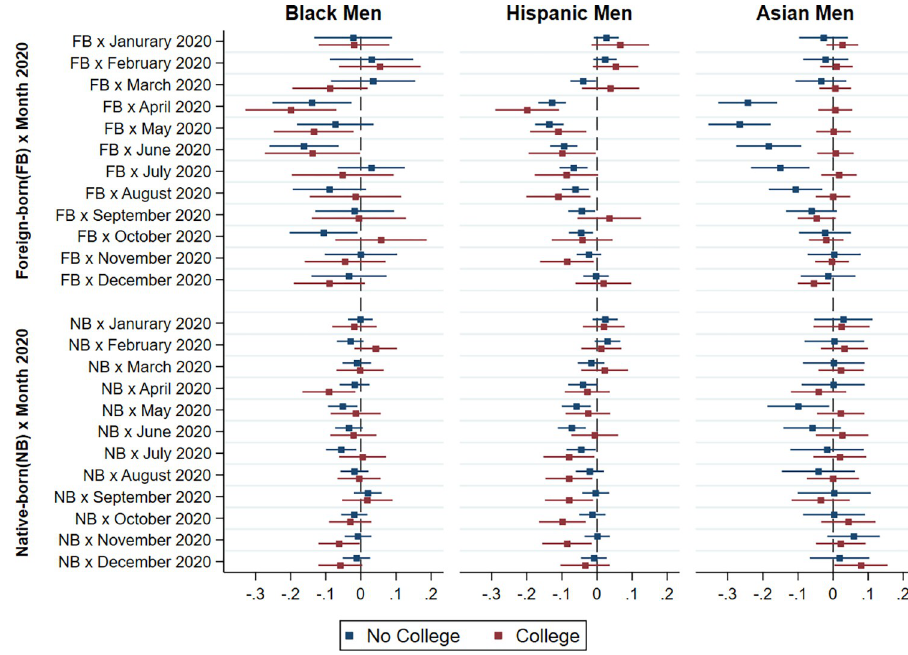
Fig 5. Difference in probability of full-time employment between non-White and native-born White men by immigrant status, race/ethnicity and education in 2020 relative to 2019.